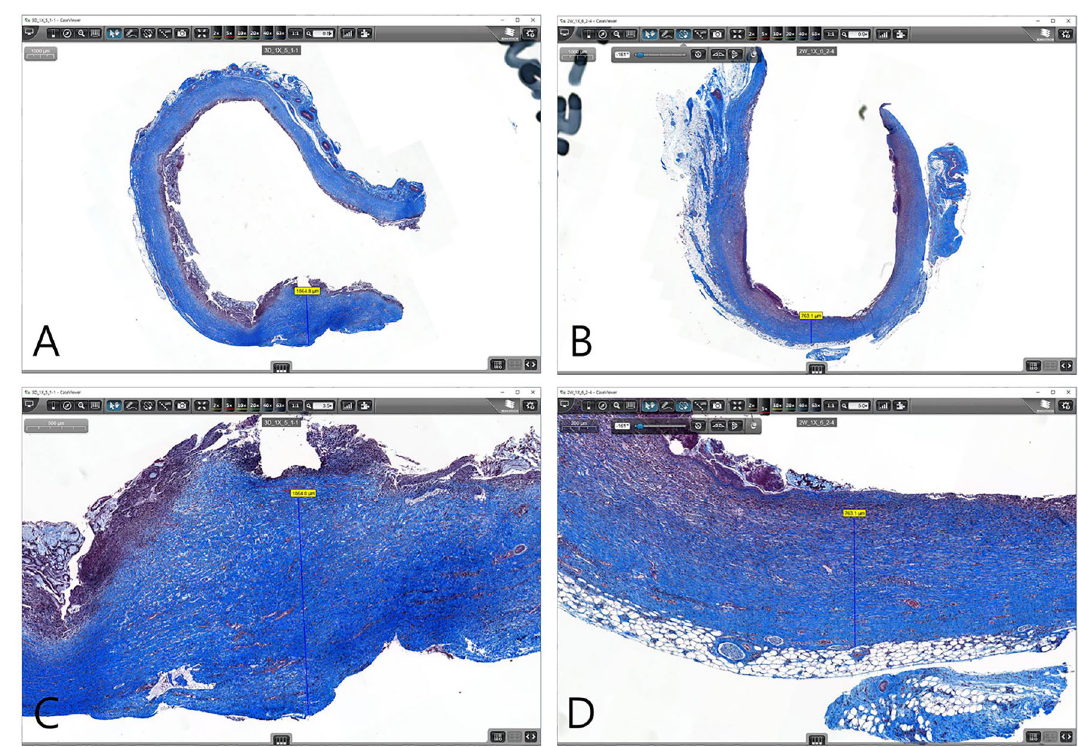
Figure 7. Measurement of periductal fibrosis (fibrous wall thickness). The thickness of bile duct fibrosis was measured using the distance measurement tool in CaseViewer software (3DHistech). The thickest ( A ) and the thinnest areas ( B ) were measured in a region of dense collagen deposition under the muscle layer by Masson’s trichrome staining. ( C ) Magnified image of ( A ). ( D ) Magnifified image of ( B